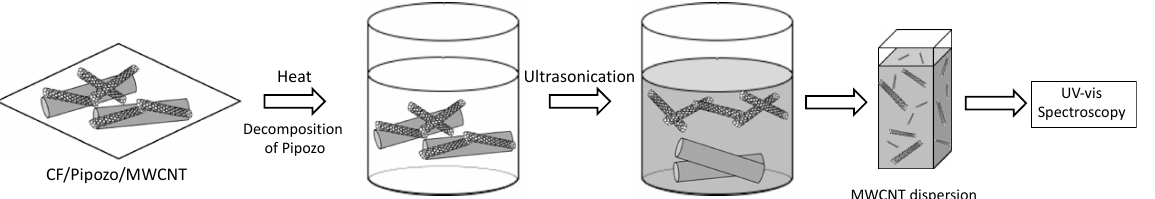
Figure 2. Process to remove MWCNTs (the second layer) from CF surfaces by Pipozo (the first layer) through the decomposition of Pipozo and the complete elimination of MWCNTs from the surfaces of the CFs by ultrasonication in a solvent for quantitative analysis of the amount of MWCNTs using UV-vis spectroscopy.